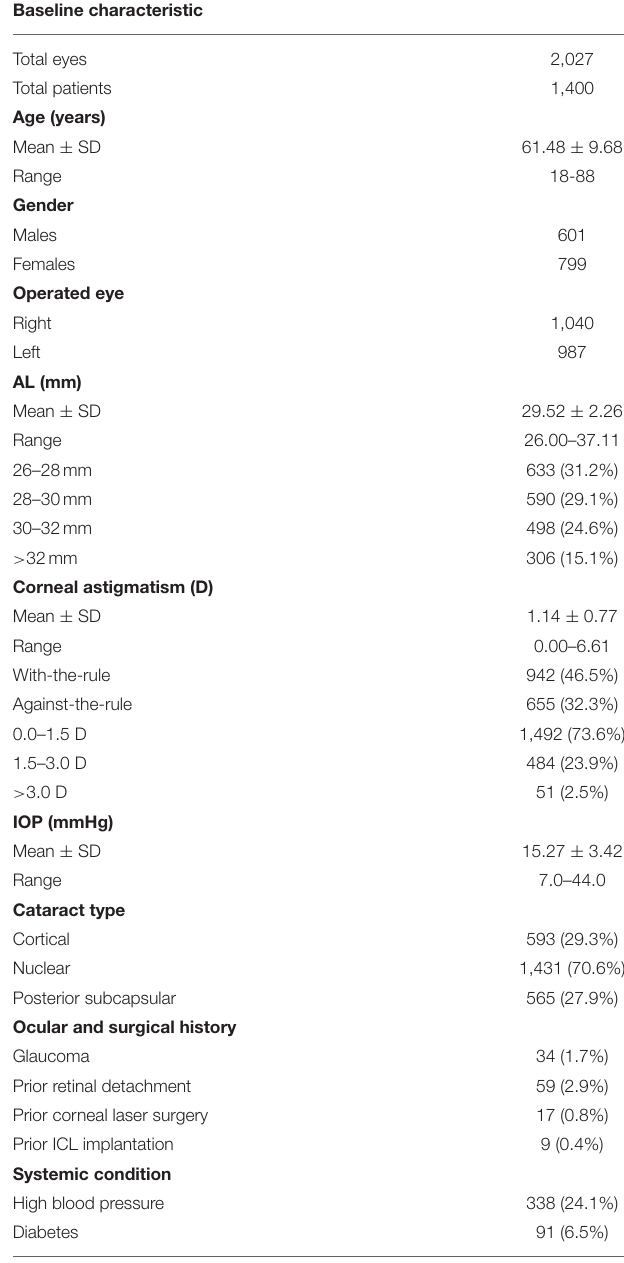
TABLE 1 | Baseline characteristics of highly myopic cataract